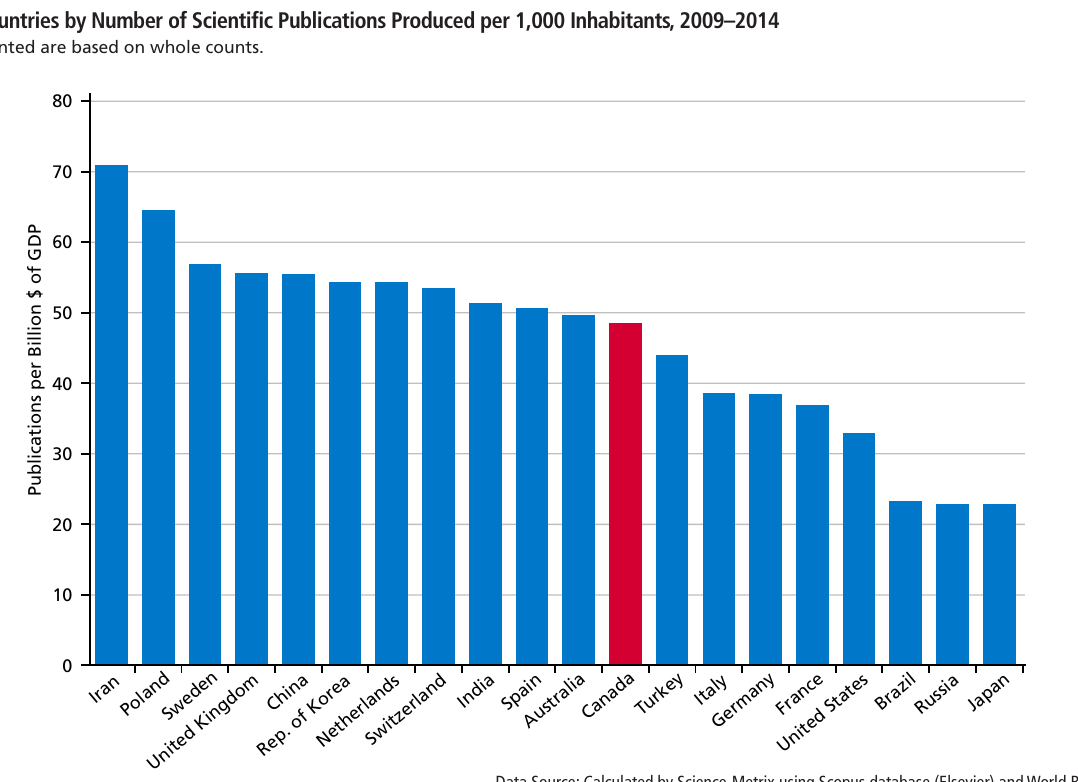
Figure 3.2 Top 20 Countries by Scientific Publications per Billion Dollars of GDP, 2009–2014 Data presented are based on whole